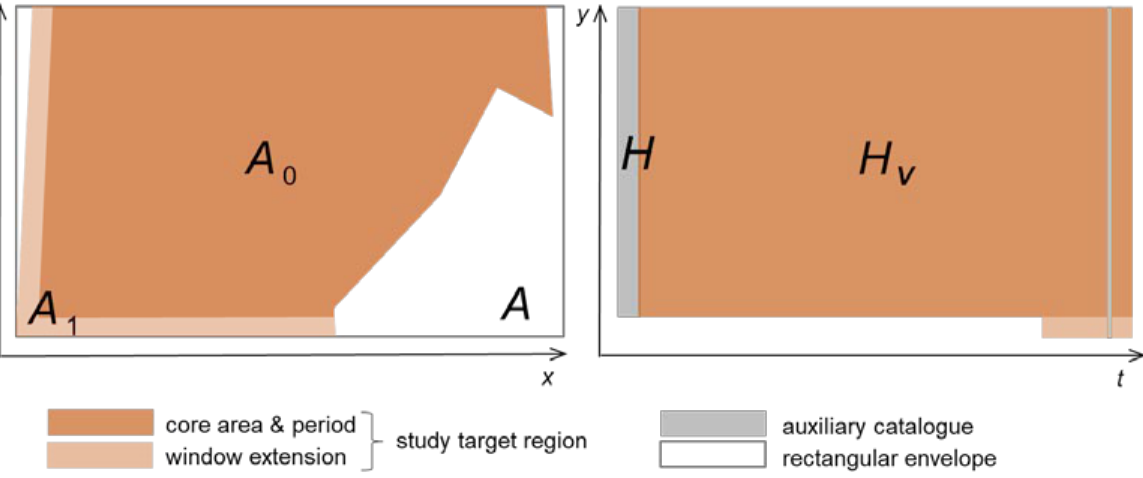
Figure 3. Schematic diagram of the space–time study target region (see also Figures 1 and 2); not to scale (the Petrinja 2020 gap is exaggerated). The auxiliary catalogue includes core window events in 1999 and the Petrinja gap events in 2020.